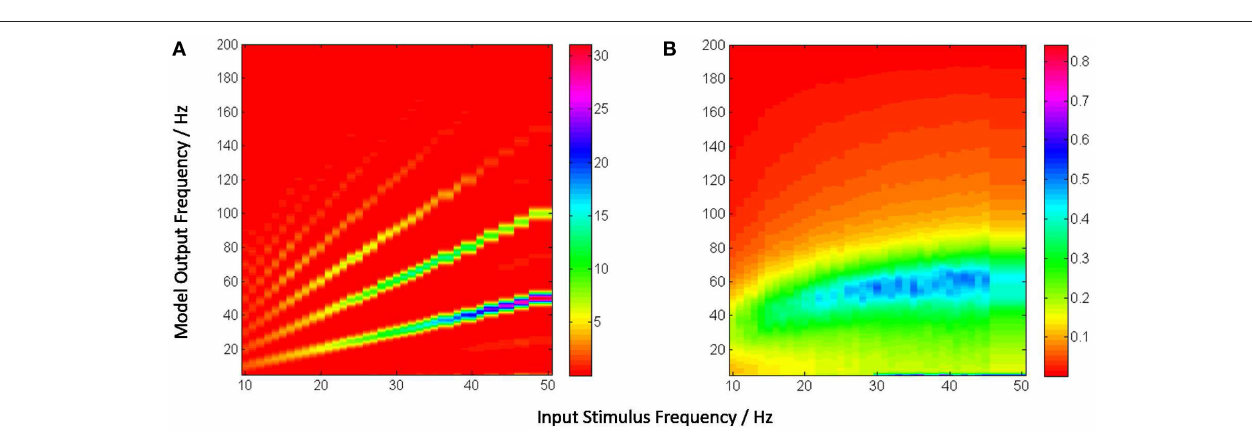
FIGURE 5 | (A) Power spectra of the model output (y-axis) show a linear relation between the fundamental response frequencies and the periodic input at frequencies in the range 10–50Hz at intervals of 1Hz (x-axis). There is a prominent second harmonic of the fundamental frequency for all frequencies in the tested range. (B) Model power spectra with a Poisson (a-periodic) input spike-train at frequency ranges similar to as in (A) . The power spectra is stationary with maximum power within the range